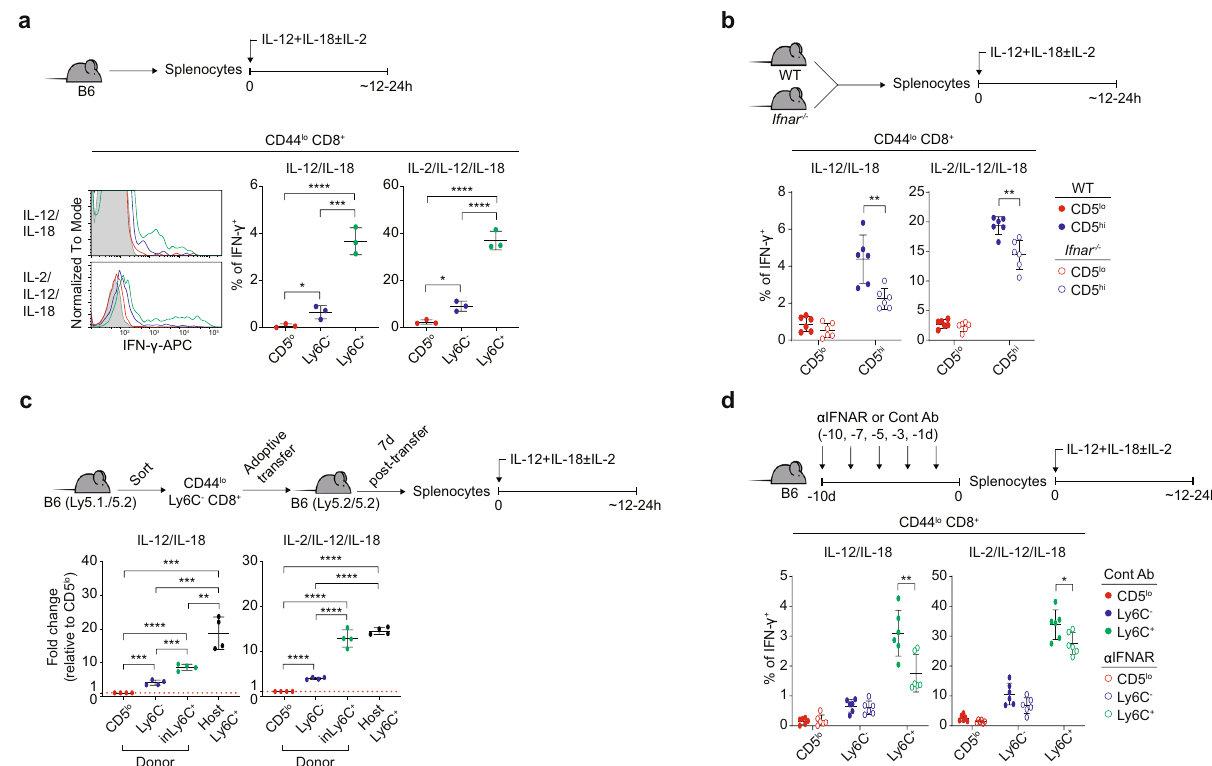
Fig. 4 Type I IFN affects functional properties of Ly6C + naive CD8 + T cells. a IFN- γ production of CD5 lo , Ly6C − , and Ly6C + B6 naive CD8 + T cells ( n = 3 mice for each group). b IFN- γ production of CD5 lo and CD5 hi naive CD8 + T cells from WT or Ifnar − / − mice ( n = 6 mice for each group). c Relative IFN- γ production of CD5 lo , Ly6C − , induced Ly6C + (inLy6C + ) donor cells and host Ly6C + cells ( n = 4 mice for each group). d IFN- γ production of CD5 lo , Ly6C − , and Ly6C + B6 naive CD8 + T cells pretreated with Control Ab or anti-IFNAR1 Ab in vivo ( n = 6 mice for each group). Statistical signi fi cance was con fi rmed by two-tailed unpaired Student ’ s t -test. Results are shown as mean ± SD. Data representative of 2 – 3 independent experiments. Source data are provided as a Source data fi